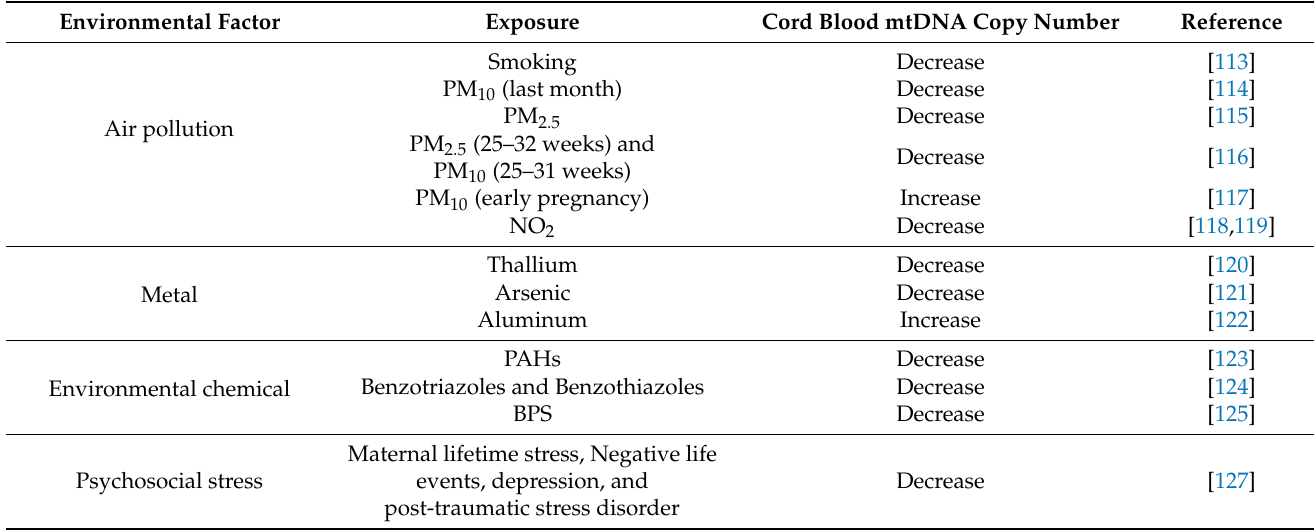
Table 1. Recent epidemiological studies on environmental factors during pregnancy and cord blood mtDNA copy number. Environmental Factor Exposure Cord Blood mtDNA Copy